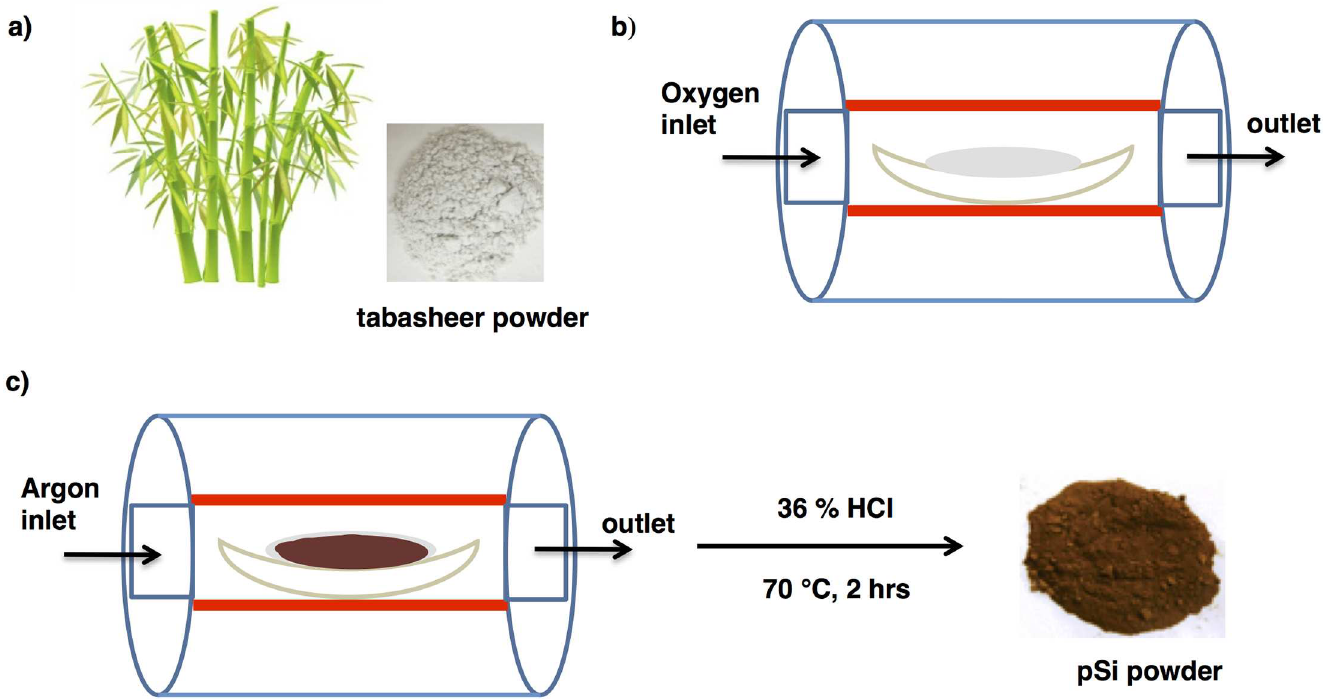
Fig 1. Eco-friendly fabrication route for extraction of pSi from tabasheer. Optical image of groundedtabasheer powder obtained from Bamboo, b ) calcination of 10% HCl washed tabasheer in a tube furnace, c ) magnesiothermic reaction of calcinatedtabasheer powder, and pure pSi powder obtained after washingwith 36% HCl.